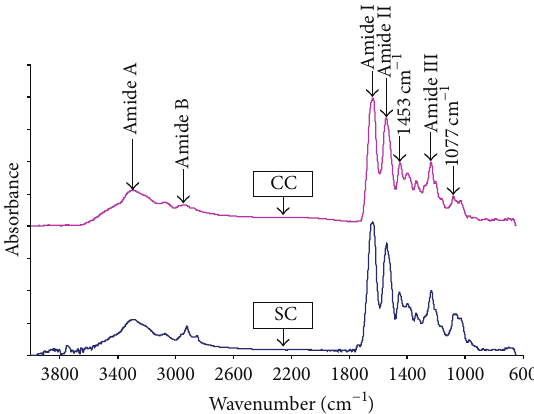
Figure 3: FTIR spectra of collagen from the skin of splendid squid (SC) and type I collagen from calf skin